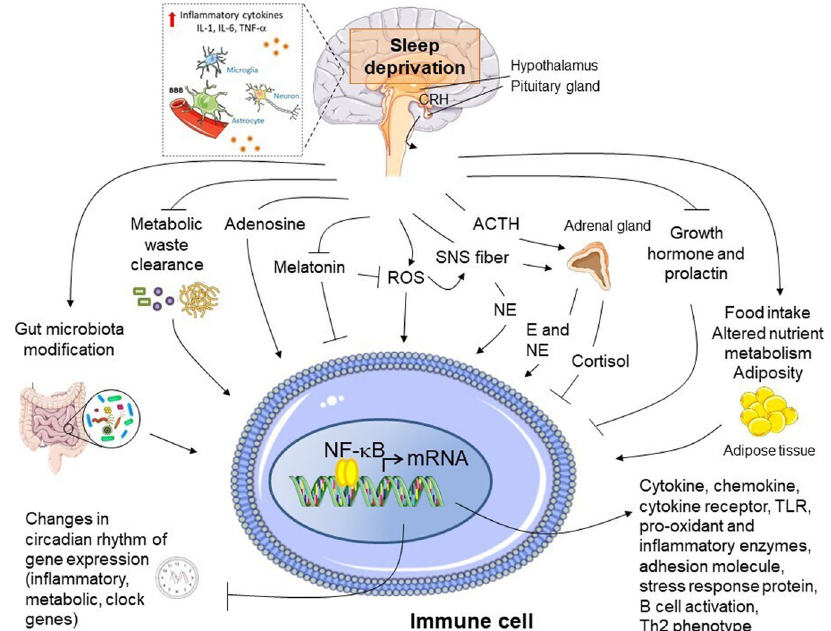
Fig. 3 Pro-in fl ammatory molecular pathways induced by sleep deprivation. A schematic model of potential mechanistic pathways linking sleep deprivation and in fl ammatory immune activation is depicted. Sleep deprivation is associated with activation of the sympathetic nervous system and release of norepinephrine and epinephrine into the systemic circulation, as well as to some extent with impaired hypothalamus-pituitary axis stimulation. These neuromediators may act along with other potential stimuli accumulated following sleep deprivation including reactive oxygen species (ROS), adenosine, metabolic waste products (e.g., β -amyloid) not cleared during normal sleep, gut microbiota dysbiosis leading to altered local and systemic pattern of metabolic products, as well as with changes in the pro fi le of neuro-endocrine hormones, such as prolactin, growth hormone, and altered circadian rhythm of melatonin secretion. In immune cells located in the brain and the peripheral tissues, these stimuli may in concert trigger in fl ammatory activation, with release of cytokines, chemokines, acute phase protein, etc. via the recruitment of transcriptional regulators of pro-in fl ammatory gene expression, mainly nuclear factor (NF)- κ B, and disturbing the circadian rhythmicity of gene expression of both clock genes and metabolic, immune and stress response genes (see text for further detail). E: epinephrine; NE: norepinephrine; TLR: Toll-like receptor. Arrows indicate stimulation; lines indicate inhibition. The illustrations were modi fi ed from Servier Medical Art (http://smart.servier.com/), licensed under a Creative Common Attribution 3.0 Generic